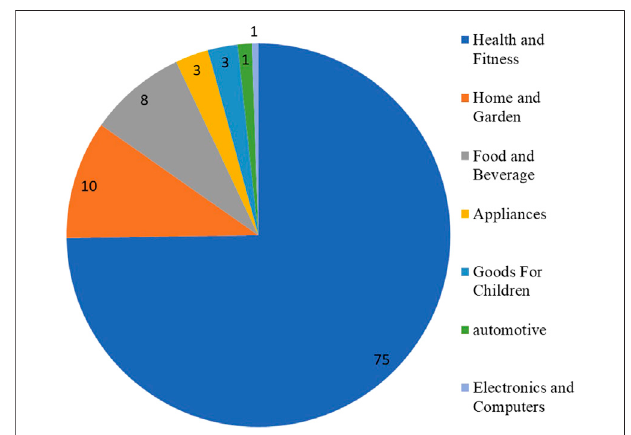
FIGURE 1 | Percentage of products containing AgNPs by categories (source: year 2021, The Nanodatabase, https://nanodb.dk/en/). The Nanodatabase is developed by the DTU Environment, the Danish Ecological Council and Danish Consumer